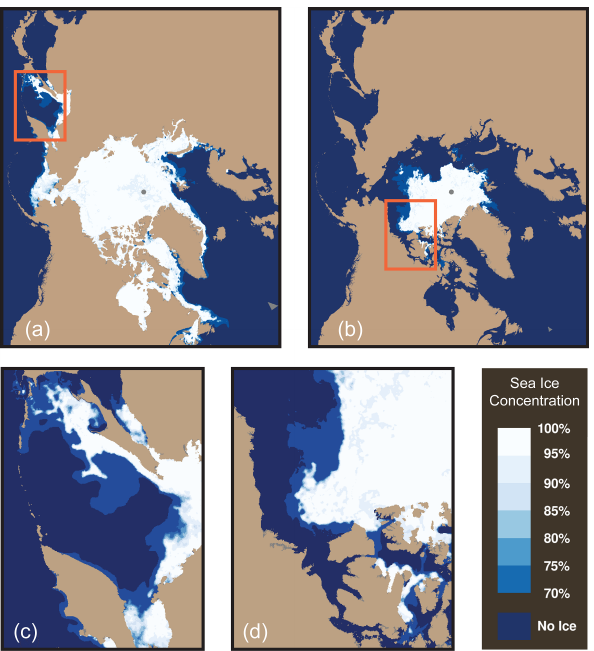
Figure 5. AMSR2 and IMS/MASIE blended ice concentration (%) products for (a) 15 March 2014 – winter and (b) 15 September 2014 – summer. If IMS/MASIE and AMSR2 indicate ice, then the great- est of 70% or the AMSR2 ice concentration value is used. If IMS/MASIE indicates ice and AMSR2 has none, then 70% (light blue) is used as ice concentration value. The zoomed areas (c) and (d) can be compared with (c) and (d) in Fig. 4 to see the effect of filling with 70% in the blended product. Note the detail in the Beaufort Sea ice edge. A prototype version of the blended product is available from NSIDC (Fetterer et al.,